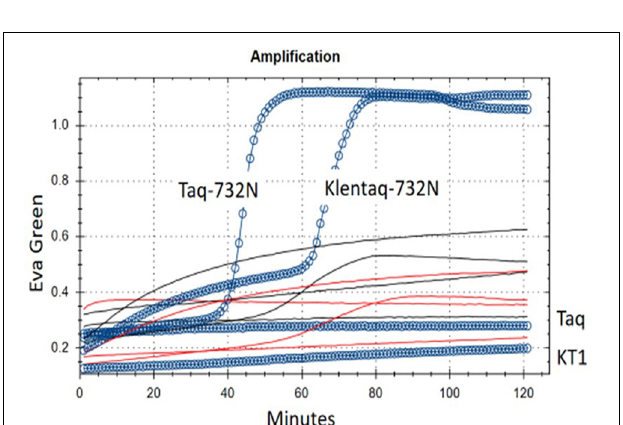
FIGURE 3 | RT-LAMP of MS2 RNA using single-enzyme Taq-D732N or Klentaq1-D732N. Shown are real-time fluorescence traces of reactions with 1/3 µ l test enzyme but no RT (reverse transcriptase) enzyme and no Mn ++ , using Eva Green fluorescence as indicator of double-strand DNA amplification. Blue circles/line: complete 26 µ l reaction, with 3 ng MS2 RNA. Black lines: MS2 RNA preincubated with RNase I. Red lines, no MS2 RNA added. Taq and KT1 : Controls wild-type Taq (full-length) and Klentaq1 (N-terminal deletion of 278 a.a.) DNA polymerase. Buffer conditions are 50 mM Tris–HCl pH 8.55, 8 mM ammonium sulfate, 200 µ M each dNTP, 0.75 M betaine, 0.025% Brij-58, 68 ◦ C. Melt curves for this experiment are shown in Supplementary Figure 2